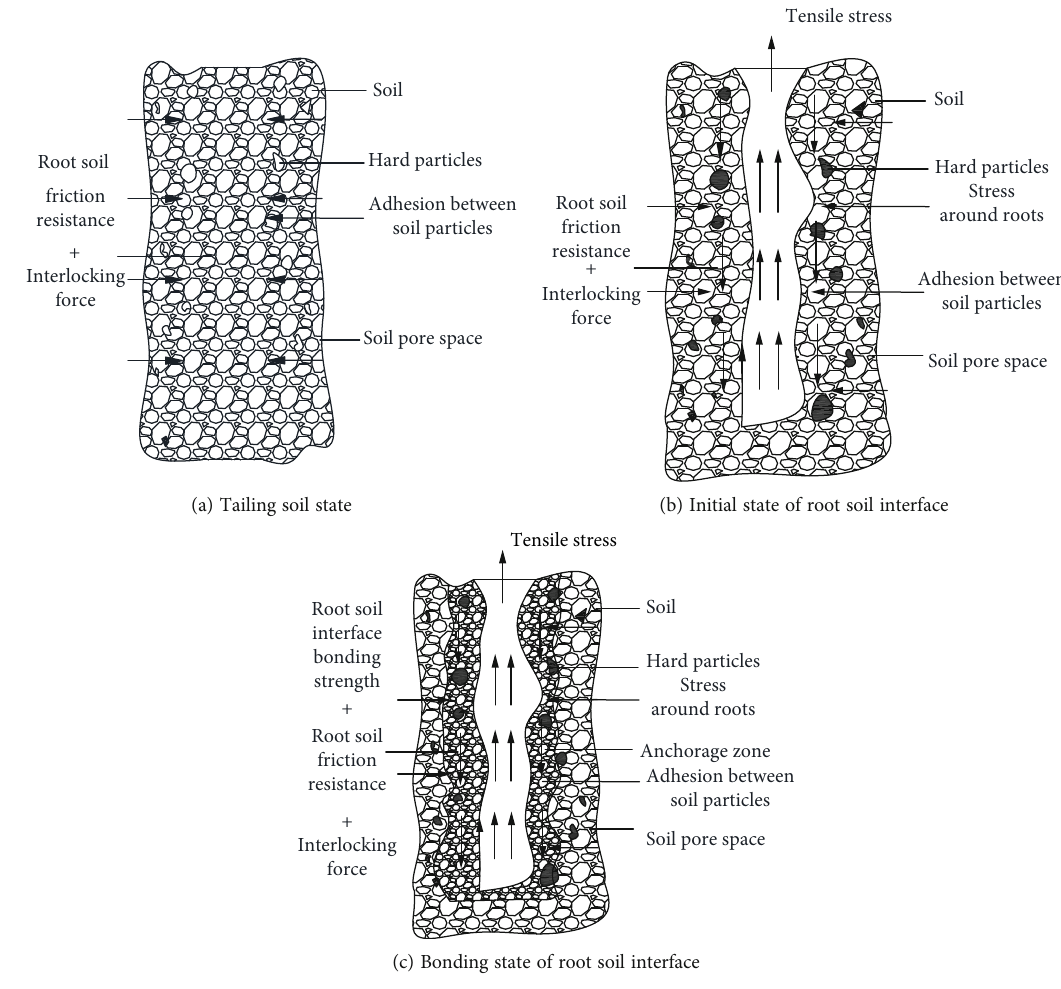
Figure 12: Schematic diagram of interface action between tailing soil and root